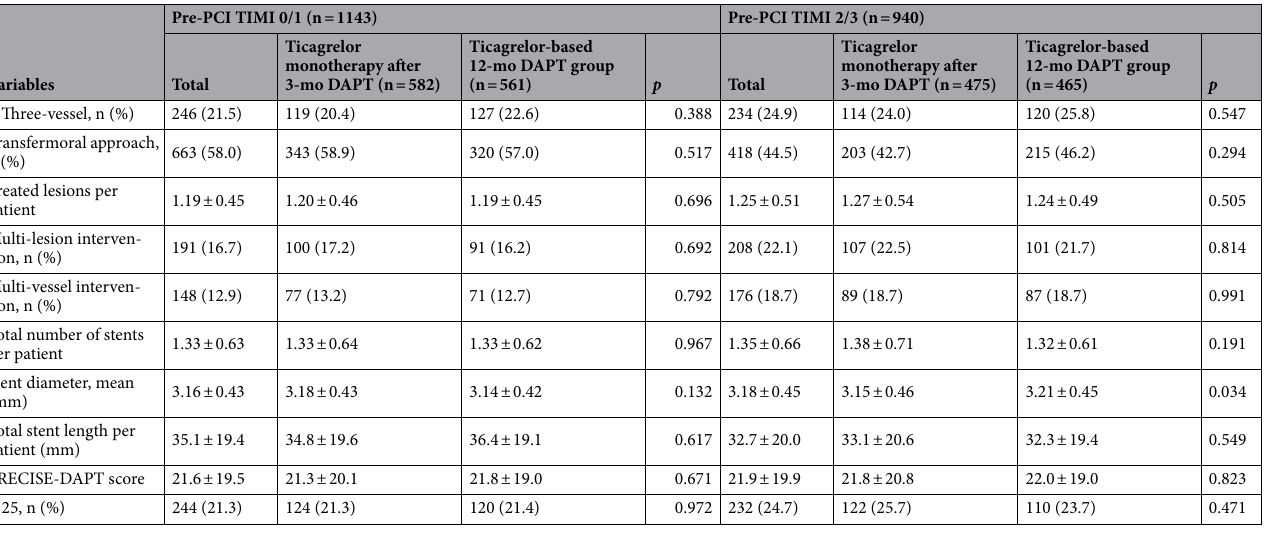
Table 1. Baseline clinical, laboratory, angiographic and procedural characteristics. Values are mean ± SD or n (%). The p values for continuous data obtained from analysis of the unpaired t-test. The p values for categorical data obtained from chi-square test. Pre-PCI pre-percutaneous coronary intervention, TIMI Thrombolysis In Myocardial Infarction, DAPT dual antiplatelet therapy, LVEF left ventricular ejection fraction, BMI body mass index, MI myocardial infarction, PCI percutaneous coronary intervention, CABG coronary artery bypass graft, HF heart failure, CK-MB creatine kinase myocardial band, eGFR estimated glomerular filtration rate,